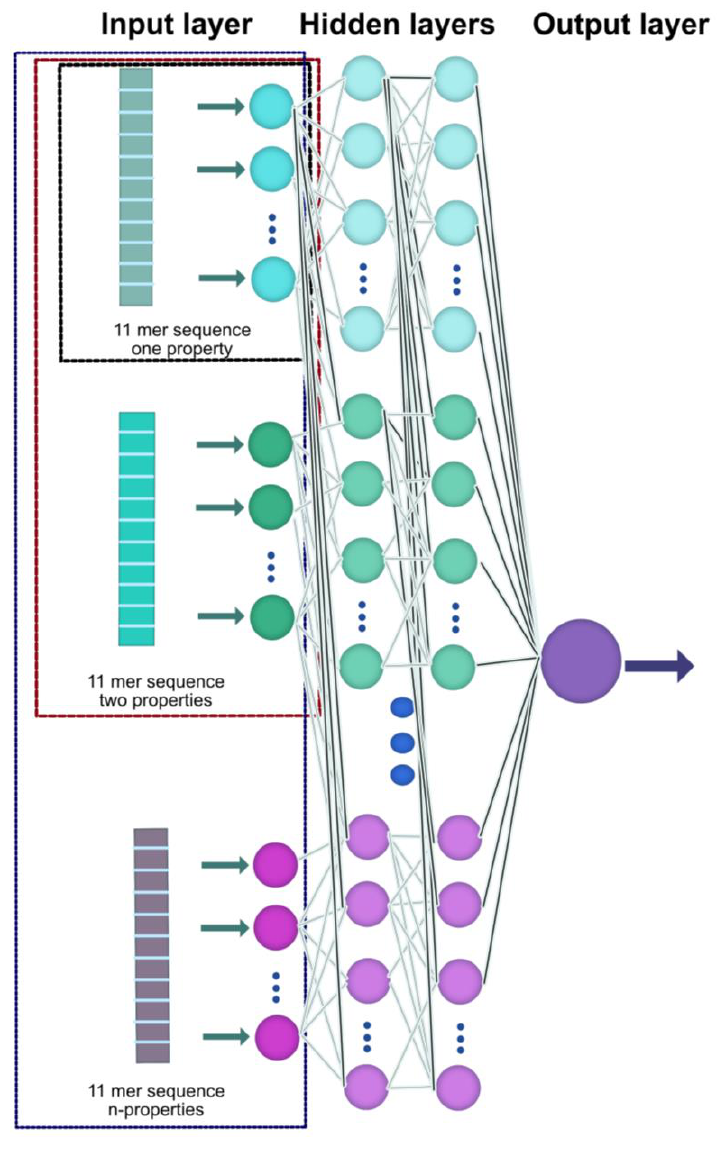
Figure 3. Schematic of the utilized ANN structure. Each of the 11mer sequences with n–features is provided to the ANN through the input layer, from which the learning process proceeds through an adjustment in the interconnections in the hidden layers. Finally, a prediction of the glycation probabil- ity is made, which is provided by the output layer. Different colors distinguish different